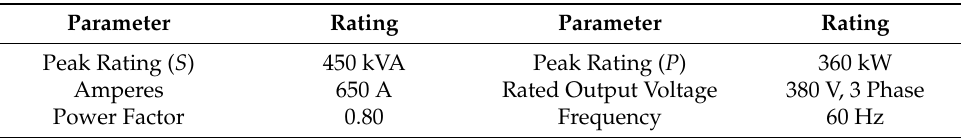
Table 2. Technical nameplate details for the generator at the Shoaiba site.